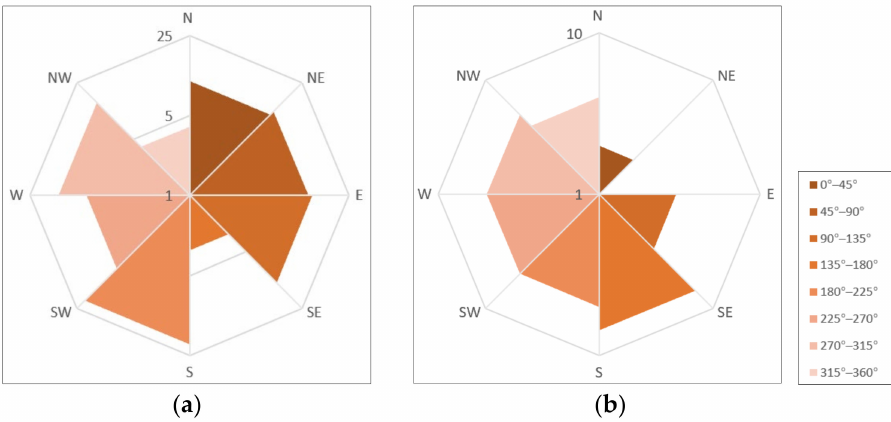
Figure 9. The features of flow direction in two regions. ( a ) radial and ( b )